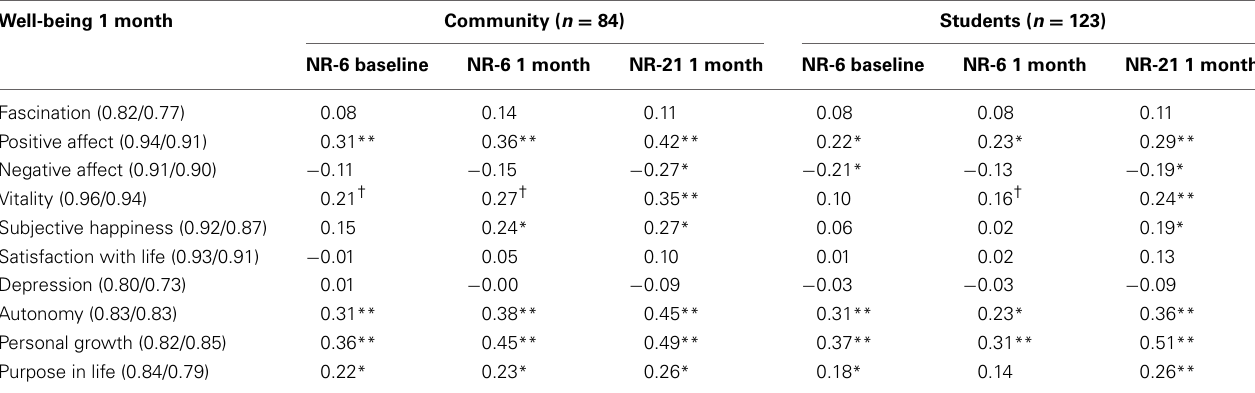
Table 6 | Study 4—nature relatedness correlations at baseline and one month with well-being at one month. Well-being 1